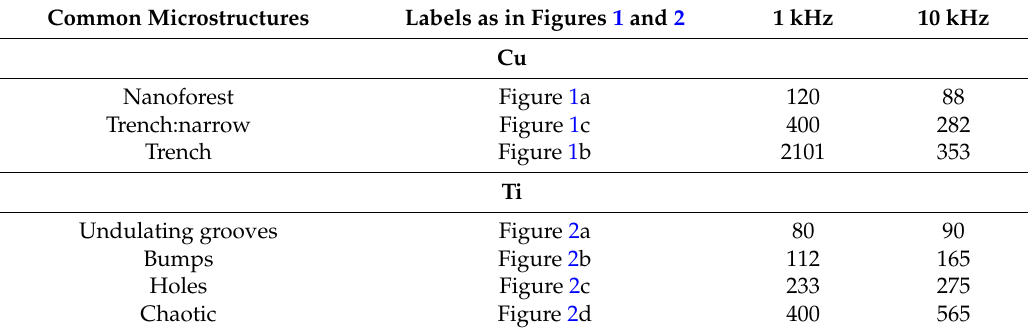
Table 3. The threshold F Σ pulse values of the common microstructures at 1 and 10 kHz [23] (in J/cm 2 ).